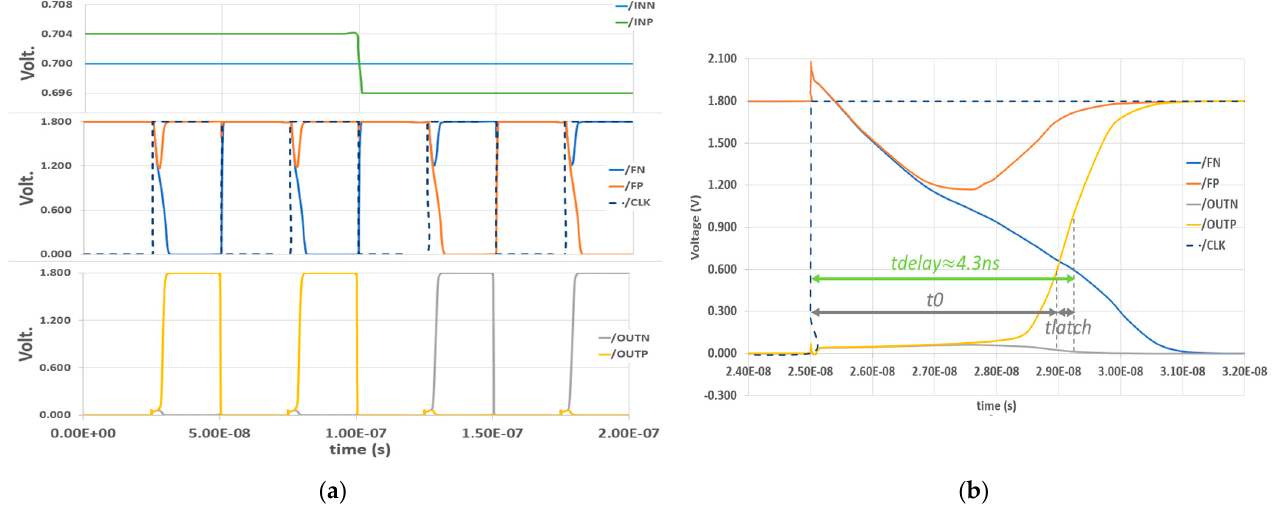
Figure 12. DT comparator post-layout simulation: (a) 4 clock cycles; (b) single clock cycle.